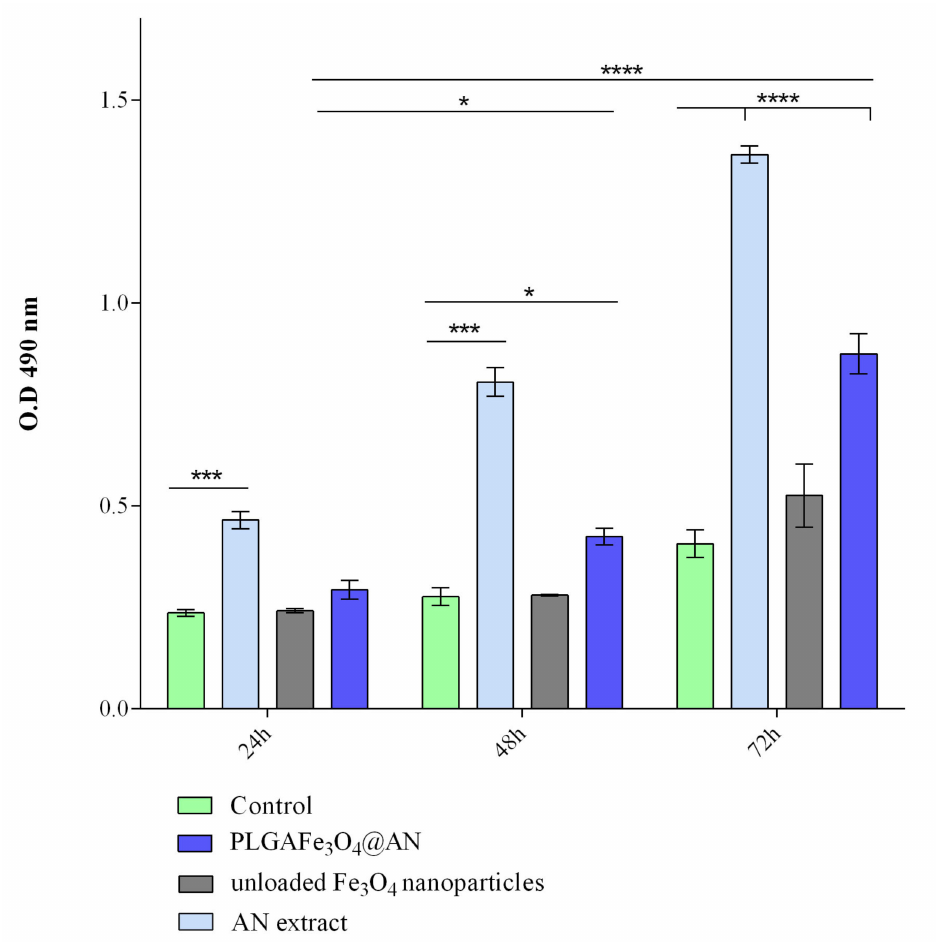
Figure 6. Cytotoxicity of the PLGA–Fe 3 O 4 @AN coatings, AN extract, and Fe 3 O 4 nanoparticle treatment after 24, 48, and 72 h of culture, as revealed by the LDH assay (* p < 0.05; *** p ≤ 0.01; **** p ≤